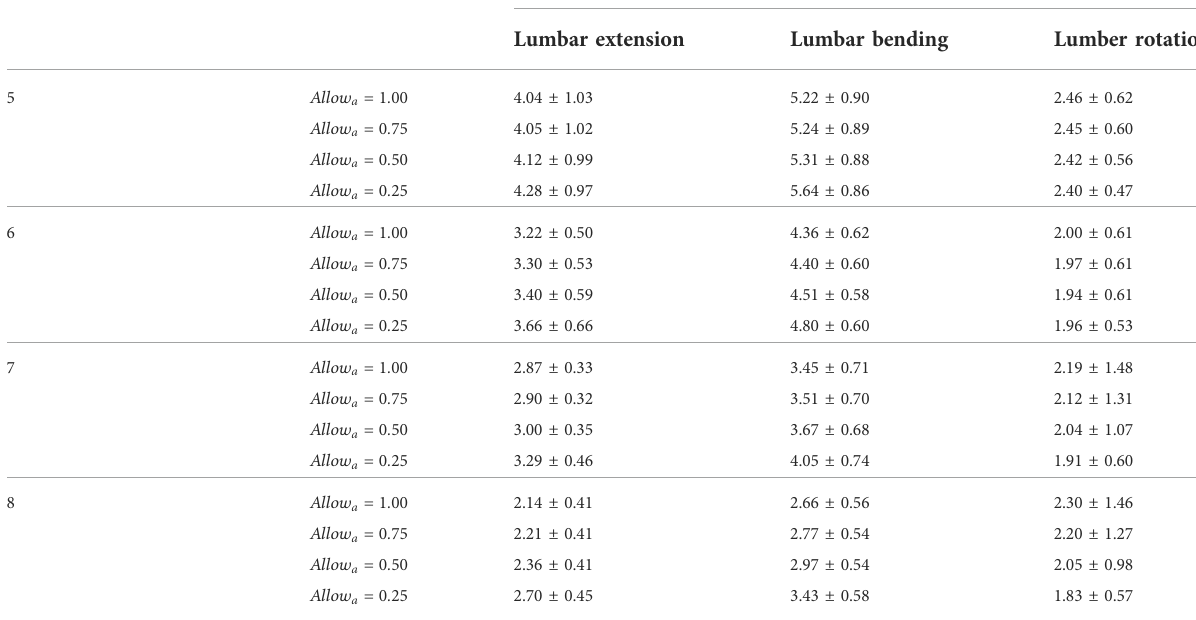
TABLE 4 The average and standard deviation of the root-mean-square error (RMSE) in the lumbosacral joint moments estimated using 5 – 8 muscle synergies per side across the 10 gait cycles selected for analysis. Allow a indicated the allowable activation value used in the optimization formulation to minimize activation ( Optimization Formulation Section